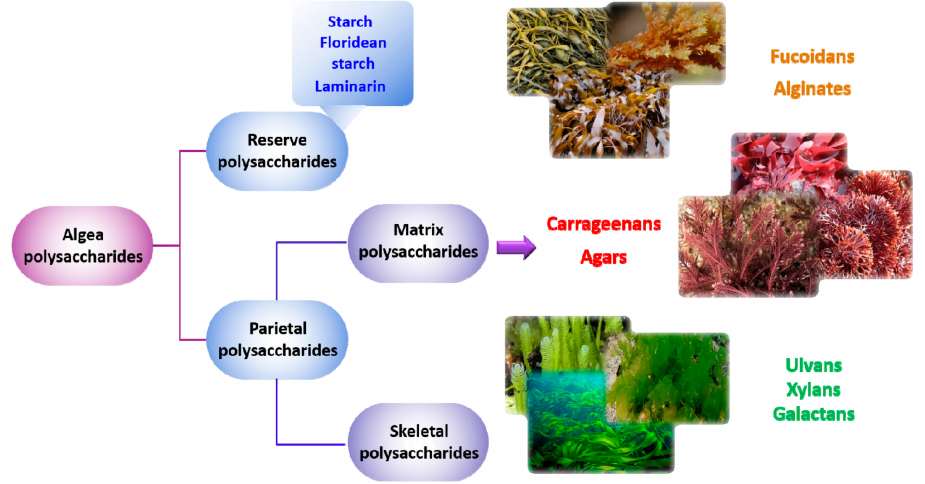
Figure 2. Algal polysaccharides classification.